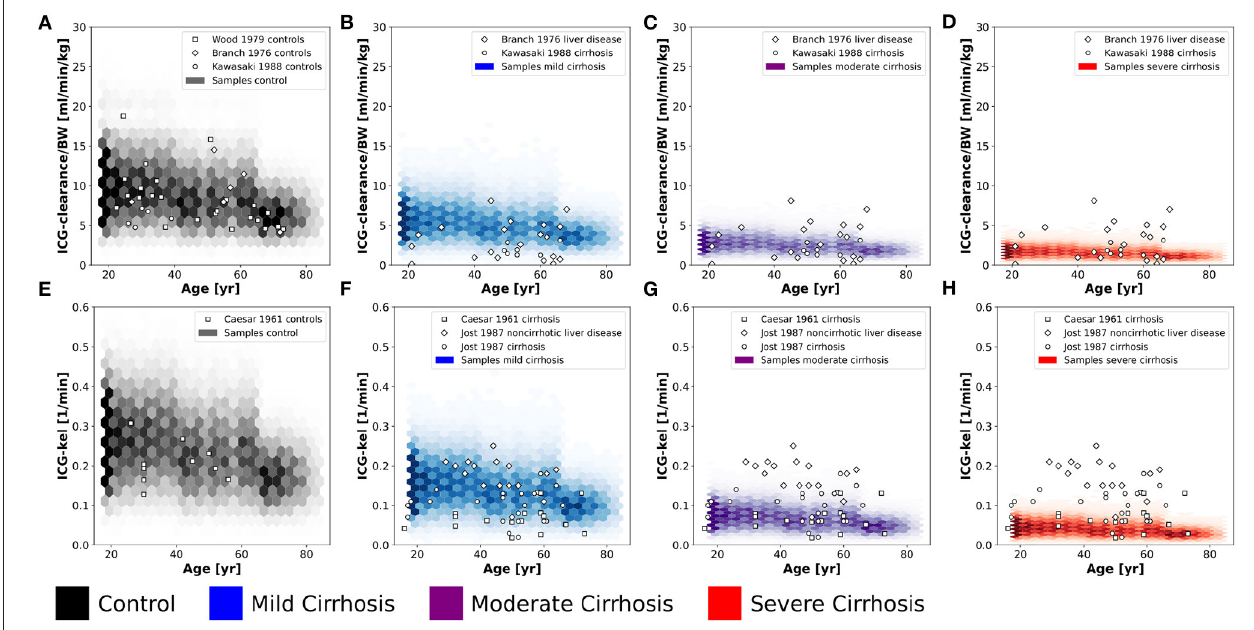
FIGURE 7 | Validation of in silico population predictions: Age dependency of ICG clearance per body weight (A–D) and kel (E–H) in the population depicted as hexbins. Simulations were performed for four different cirrhosis degrees (see section 2.1): Black, control, blue, mild cirrhosis; purple, moderate cirrhosis; red, severe cirrhosis. Clinical data of controls from Caesar et al. (1961), Branch et al. (1976), Wood et al. (1979), and Kawasaki et al. (1988), and cirrhotic subjects from Caesar et al. (1961) , Branch et al. (1976), Jost et al. (1987), and Kawasaki et al.